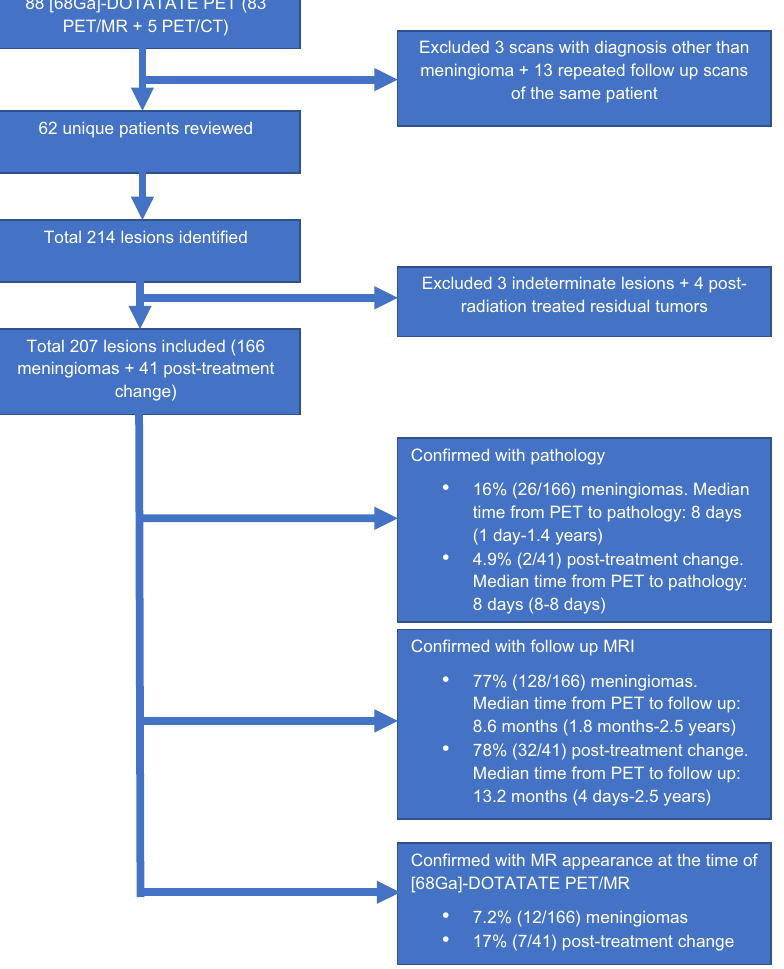
Figure 1. Flow chart of the included subjects and lesions as confirmed by each diagnostic